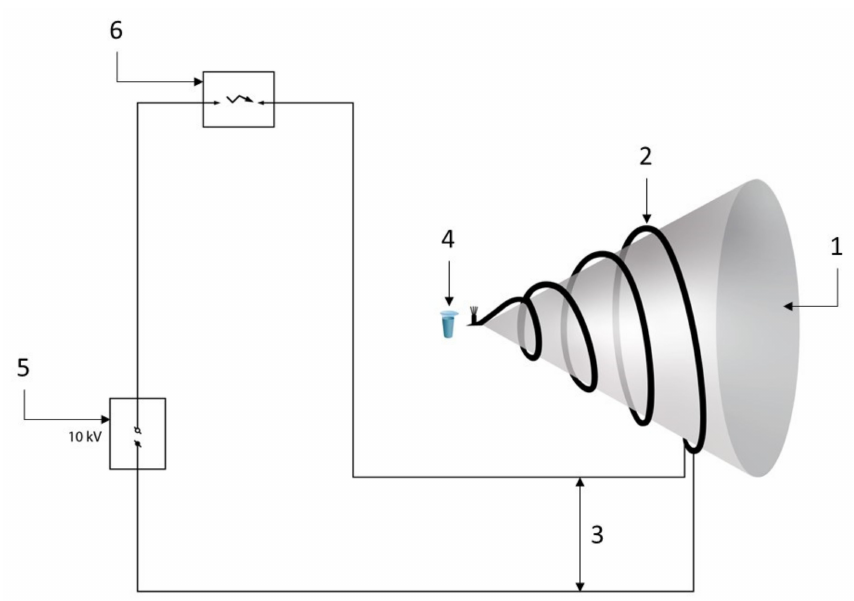
Figure 1. Experimental setup. Numbers indicate the main elements of the setup: the cone (1), the twisted pair helix (2), the soldered ends of the twisted pair wires (3), the test tube with the enzyme solution near the cone top (4), the high-voltage AC power supply (50 Hz frequency, 10 kV amplitude) unit (5), and the spark gap